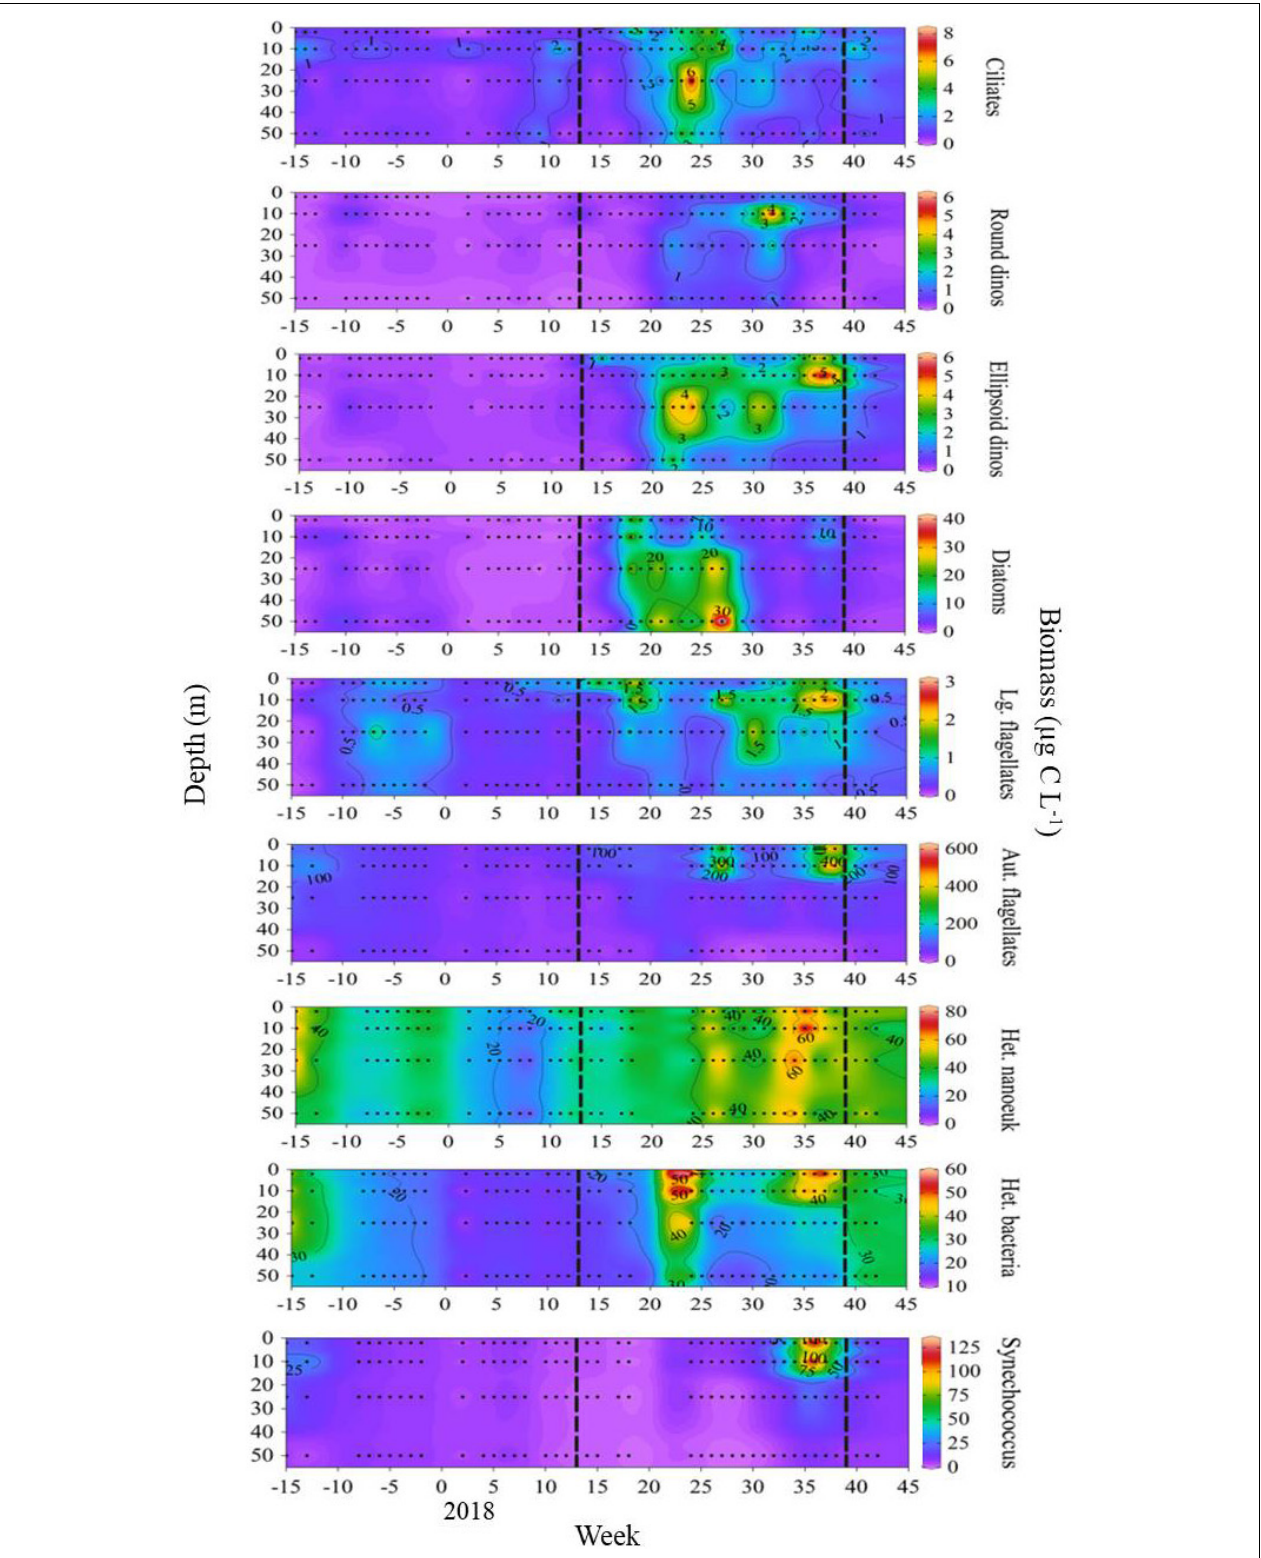
FIGURE 4 | Prey carbon biomass over the 2017–2018 study (Ocean Data View, Schlitzer, 2018). Vertical dashed lines mark the onset and breakdown of stratification, indicated by the switch in surface NHF from negative to positive (week 13), and positive to negative (week 39) during the 2017–2018 study.